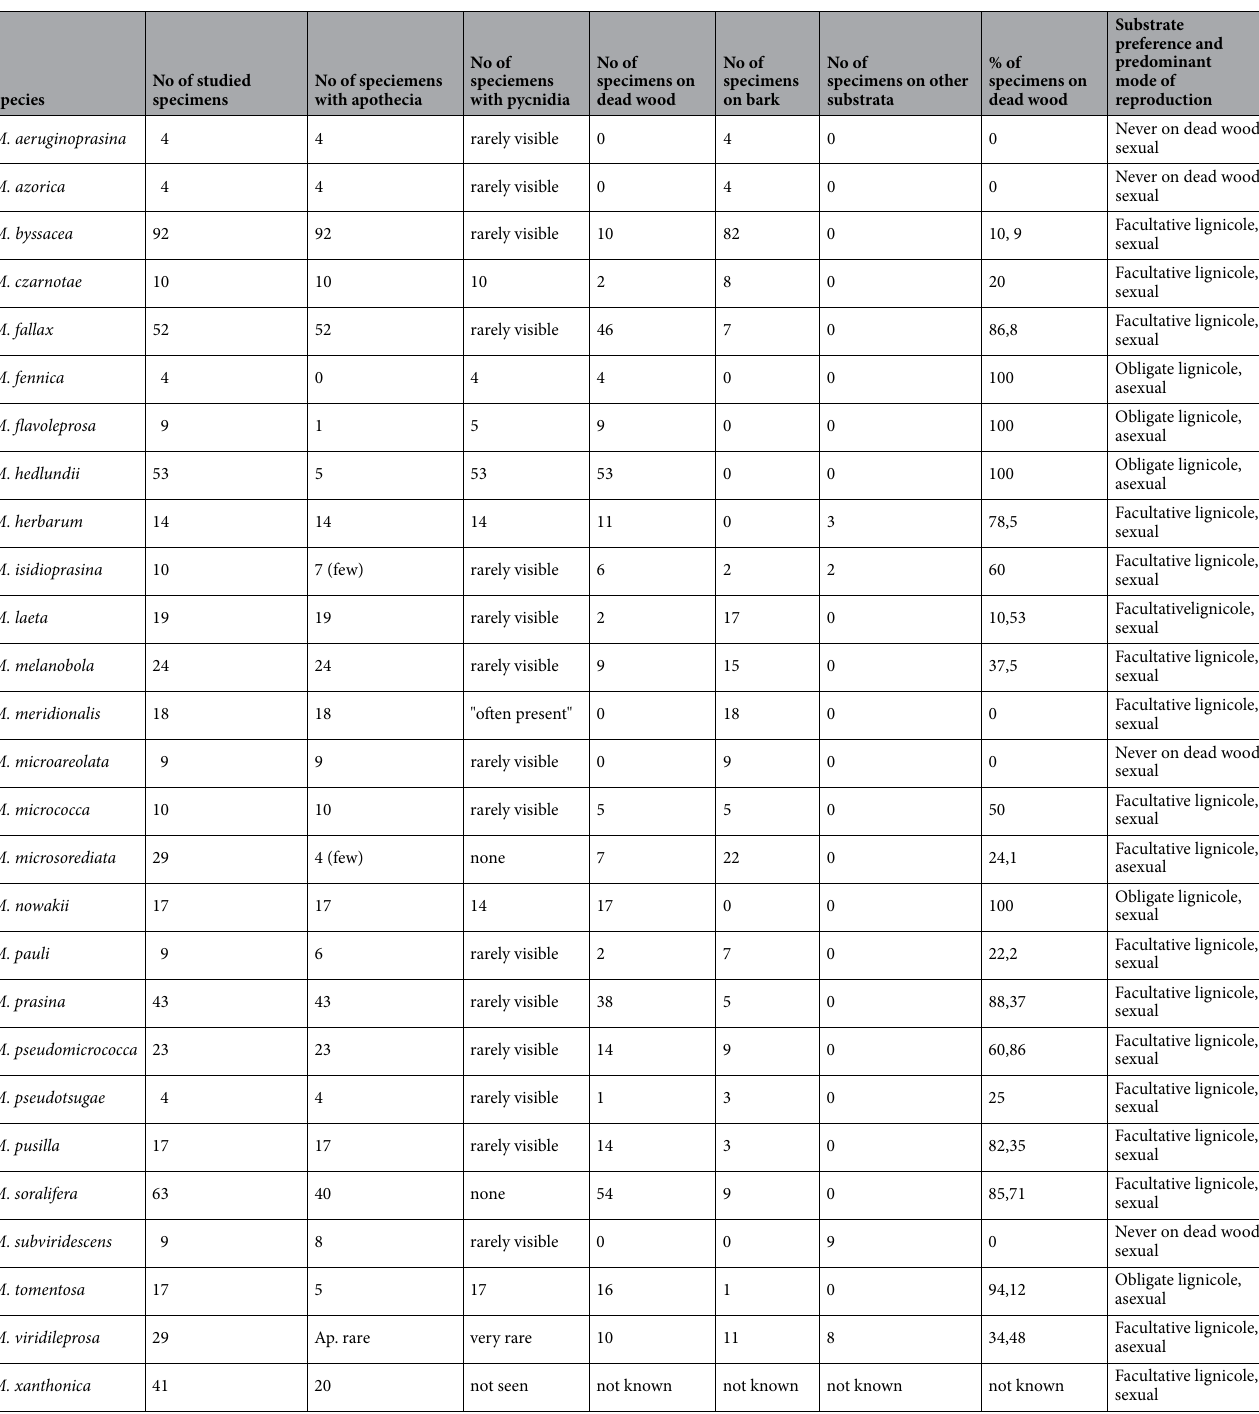
Table 3. Number of studied specimens, their reproduction mode and substrate requirement. Five species are recorded based on literature: M. herbarum and M. meridionalis 23 , M. subviridescens ( 53 and NBN Atlas online records from herbarium E), M. viridileprosa 45 and M. xanthonica 50 . Many Micarea species produce mesopycnidia that are immersed between goniocysts and may therefore be rarely